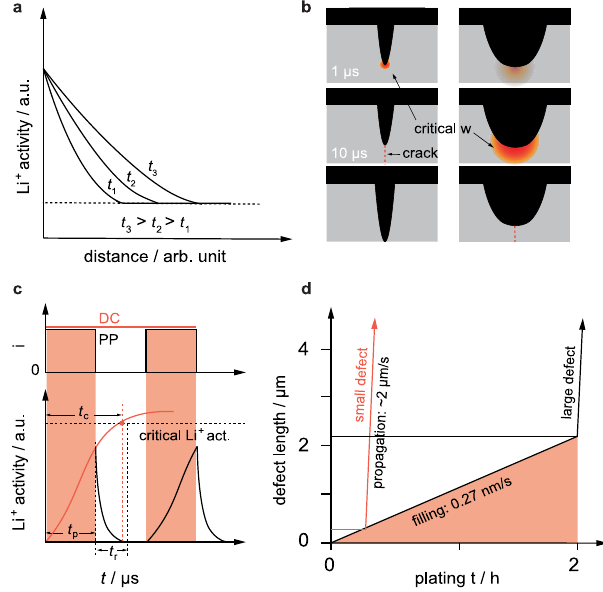
Fig. 6 | Trends and observations concerning Li activity front and defect size. a Activity front at SSE|Li interface and growth of rim with increasing time (arbi- trary chosen times t 1 , t 2 and t 3 where t 1 < t 2 < t 3 ). b Schematics illustrating that a smaller activity front (red) with a critical width w is suf fi cient to crack up the environment of small defects, (black) in the solid electrolyte (gray) whereas a thicker activity front is needed for the same result in case of bigger defects. It thereforetakesforalongertimetoinducefractureinthevicinityofbigdefectsas opposed to smaller ones. c Increase of Li activity as a function of plating time between pulse plating (PP) and direct current (DC) application. The illustration shows that if the current is applied for a shorter amount of time ( t p ) than what is needed to reach the critical Li activity ( t c ), a structural degradation can be avoi- ded/delayed, while relaxing for t r . d Time required until a defect gets critical (i.e., fi lled completely) by considering a plating rate of 0.27nm/s (assuming a current density of 0.2mA/cm 2 ), demonstrating that smaller defects are most critical in terms of fi lament initiation and propagation. Further elaborated in Supplemen- tary Note